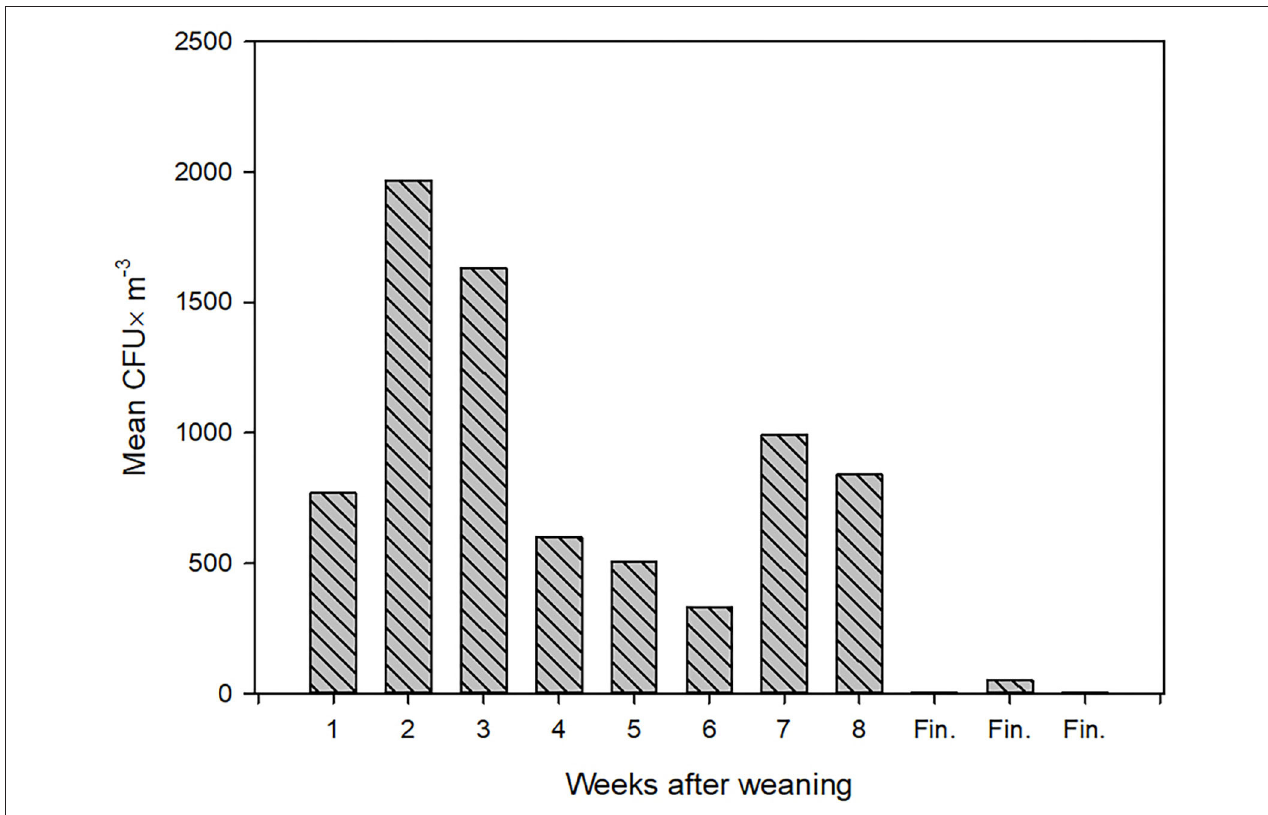
FIGURE 1 | The concentration of airborne LA-MRSA (mean values of two measurements) inside stables among group of piglets of different ages. CFU, Colony Forming Units; Fin., Finishing